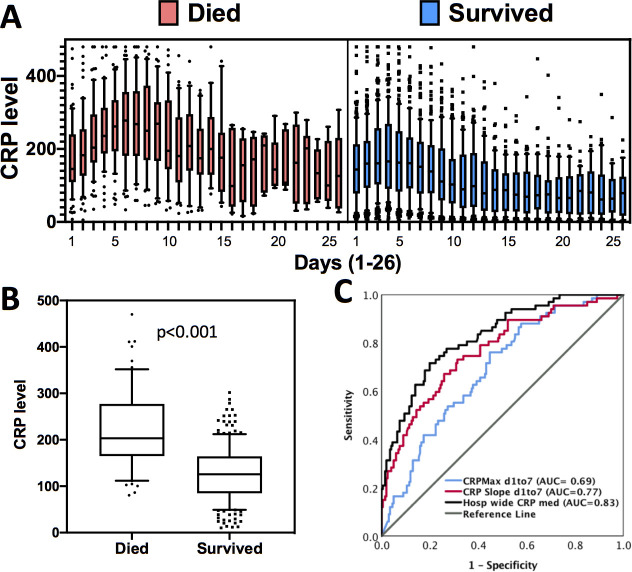
Association between CRP levels in-hospital mortality in COVID-19 patients.(A) Trends in CRP changes over time in patients who died (red) and survived (blue). (B) Comparison of median hospitalization-wide CRP levels between patients who died and survived. (C) ROC curve analysis showing predictive association between hospitalization-wide median CRP, maximum CRP within the first 7 days, and the rate of change in CRP (slope) within the first 7 days with mortality. AUC values are indicated.